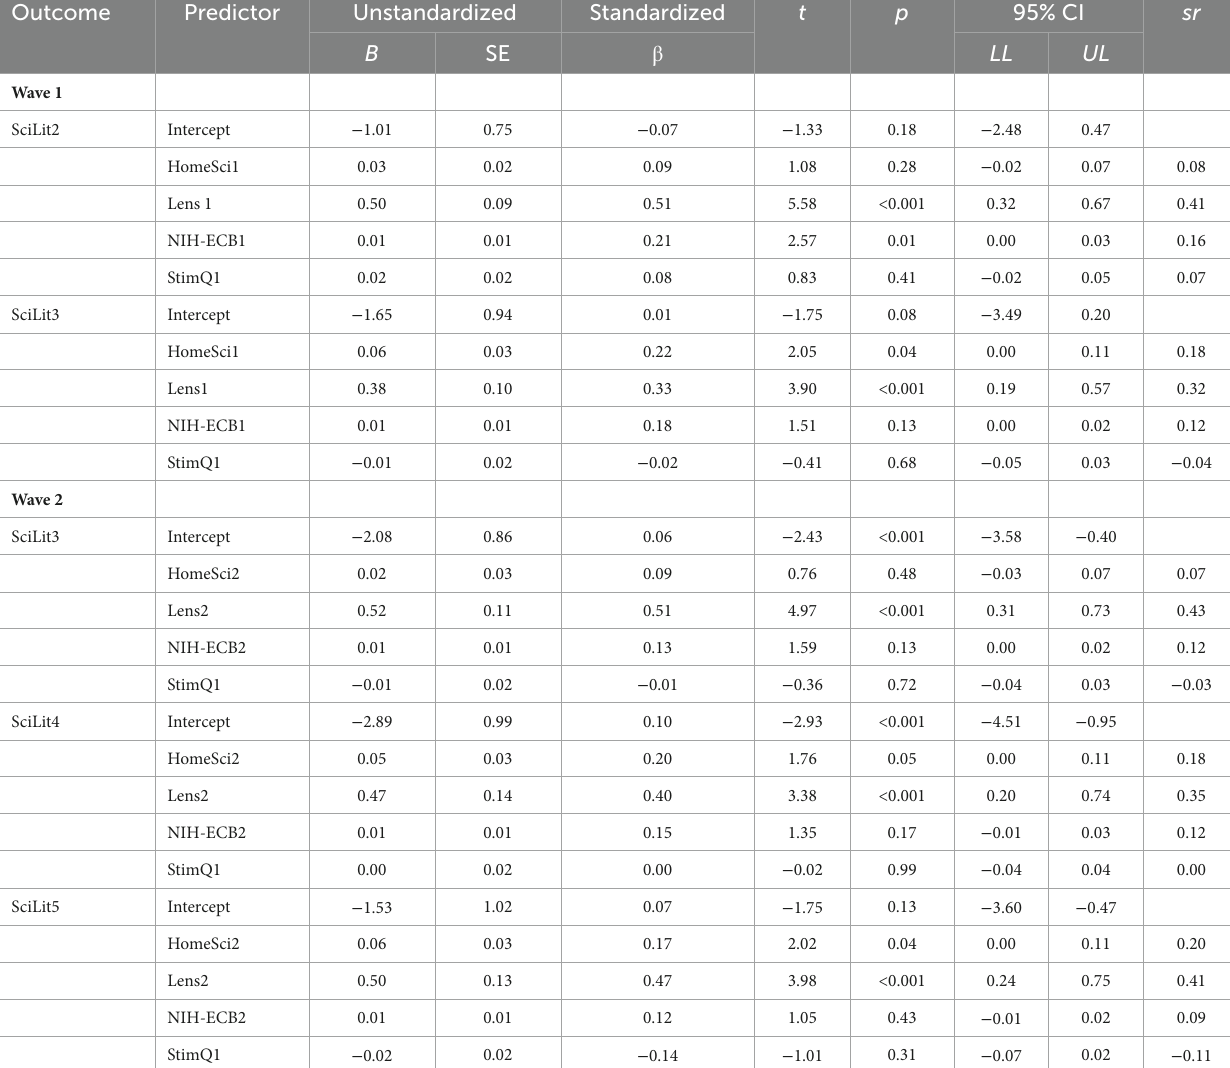
TABLE 12 Multivariate regression analysis for home science environment at Waves 1 and 2 predicting scientific literacy (with StimQ). Outcome Predictor